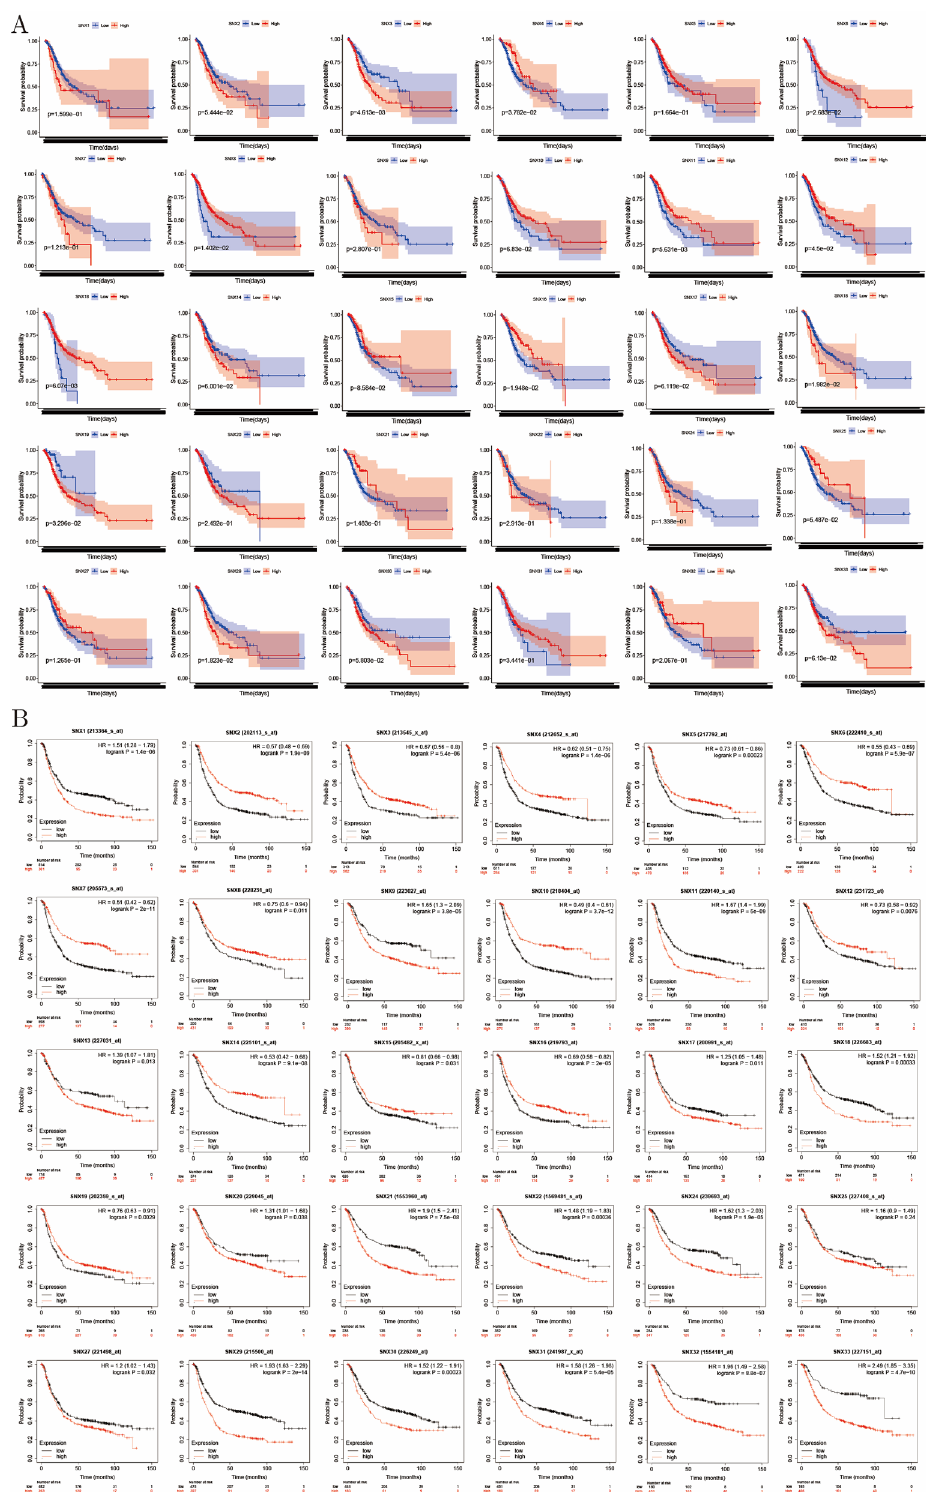
Figure 5. Kaplan–Meier survival analysis of SNX family. ( A ) SNX3/6/8/11/12/13/16/18/19/29/ showed associated with OS of GC based on TCGA clinical information, SNX23/26/28 not recorded. ( B ) GEO online analyzing tool, Kaplan-MeierPlotter, manifesting that 30 SNXs were correlated with OS of GC, with no information of SNX23/26/28